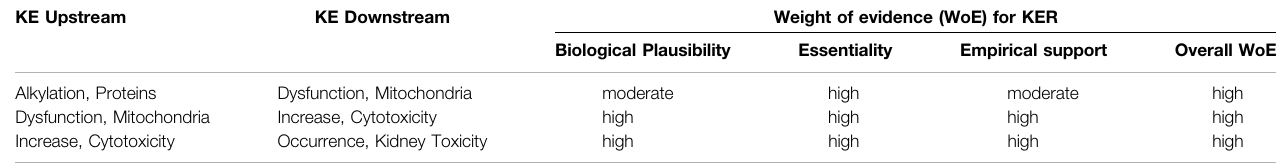
TABLE 8 | Weight-of-evidence analysis of KERs in the adverse outcome pathway of renal protein alkylation leading to kidney toxicity. KE